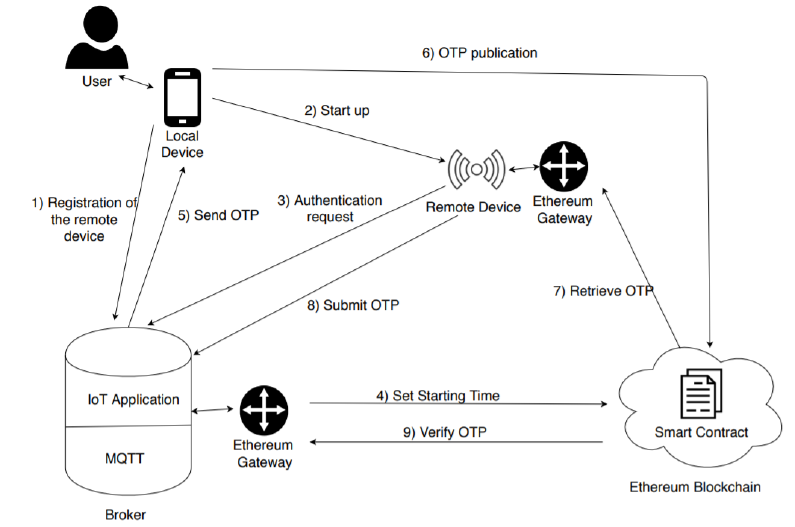
Figure 2. Realistic architecture of the proposed